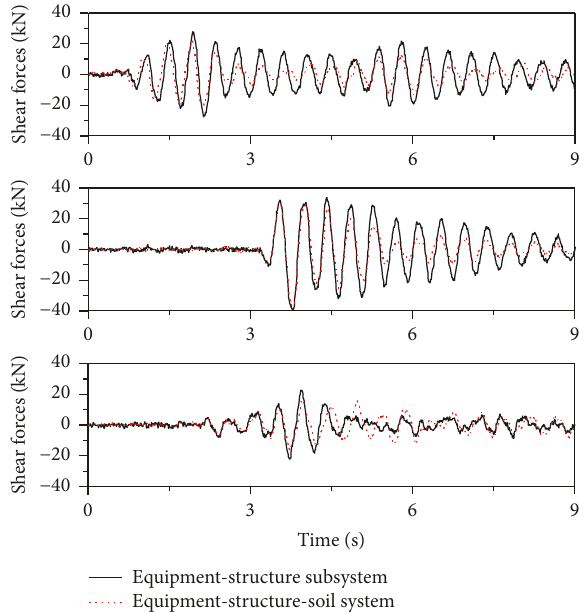
Figure 13: Shear force responses of different systems during the medium